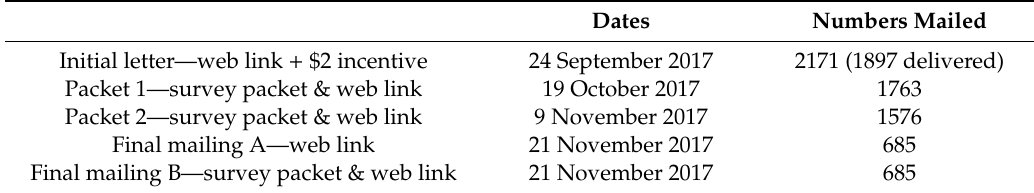
Table 1. Mailing strategy to every household within 80466 zip